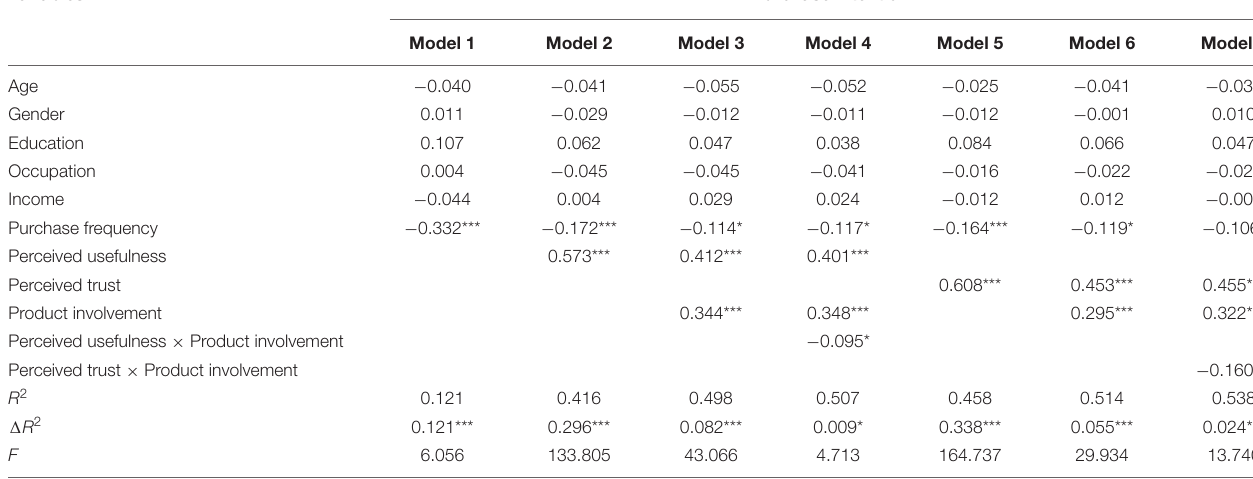
TABLE 5 | Results of the moderated regression